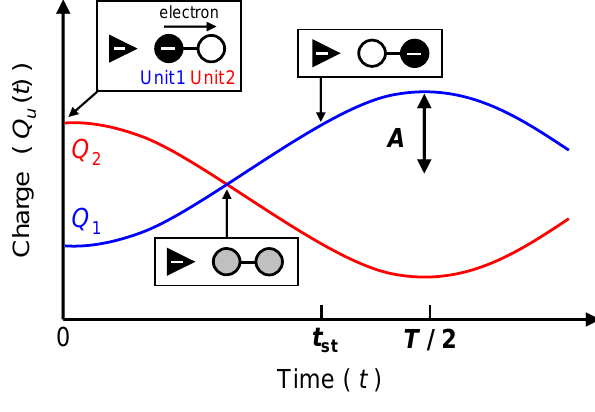
Figure 2. Simplified two site model of QCA cell and schematic picture of signal transmission between two units, unit 1 (U1) and unit 2 (U2). A , T , and t amplitude, the signal period, and the signal transmission time,